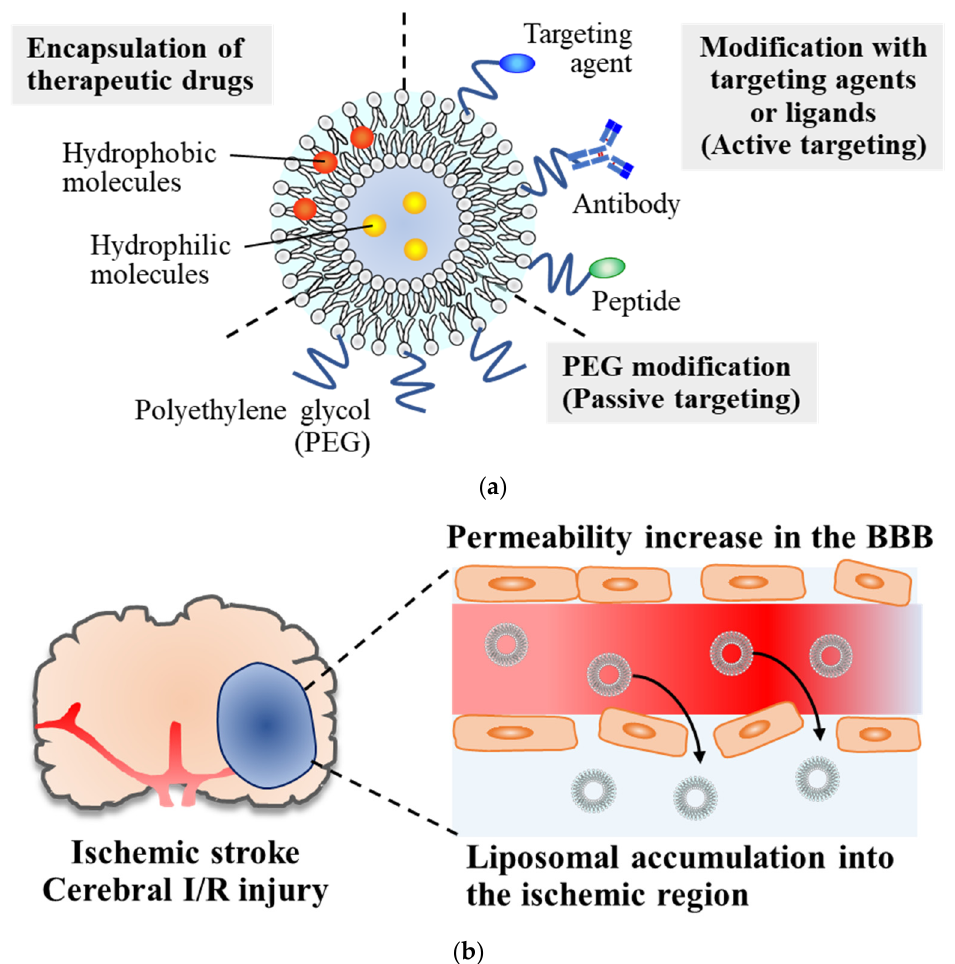
Figure 1. Application of liposome DDS for the treatment of ischemic stroke. ( a ) Schematic diagrams of liposome DDS. ( b ) Accumulation of liposomes in ischemic brain region through the disrupted BBB under conditions of ischemic stroke/cerebral I/R injury.